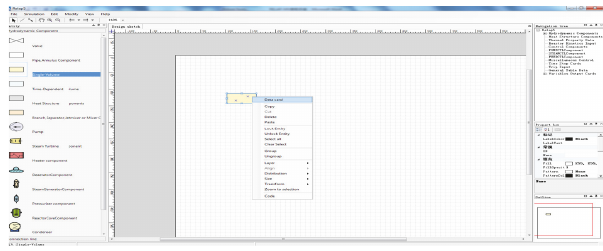
Figure 4: Single volume input